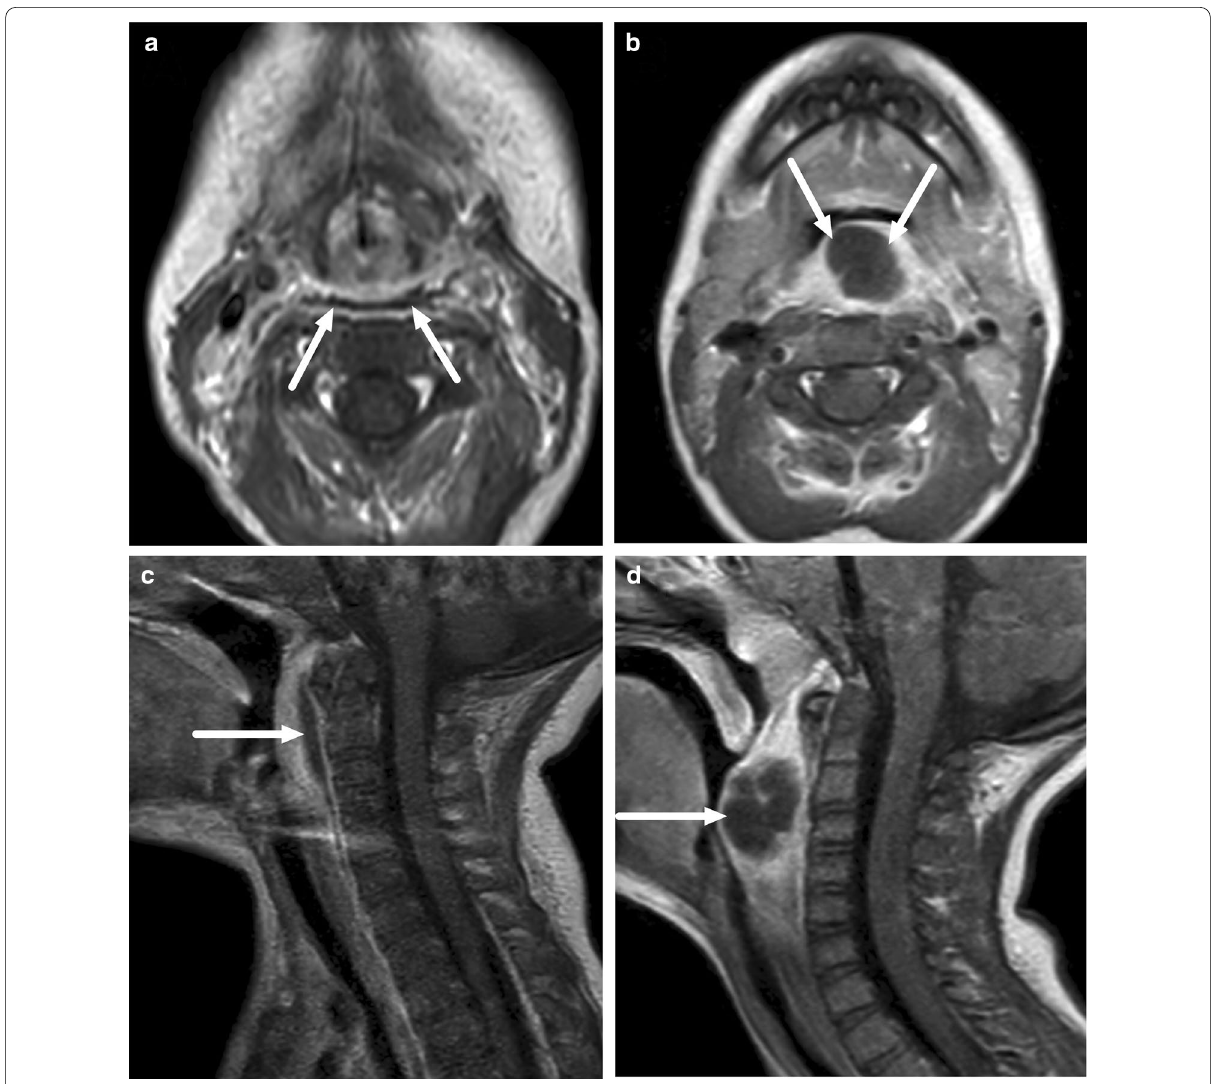
Fig. 21 Retropharyngeal abscesses (arrows) on axial ( a , b ) and sagittal ( c , d ) post-contrast T1-weighted images in two children ( a and c , b and d ). The first ( a , c ) represent a true retropharyngeal abscess as a thin collection between fascial planes, whereas the second ( b , d ) is a focal collection due to suppurative lymphadenitis. Image modified from ref.